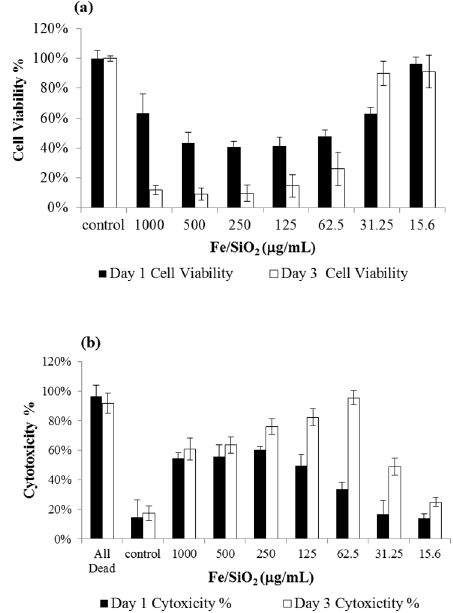
Figure 5. Results of ( a ) CCK-8 and ( b ) LDH assays of L929 cells after incubation with SiO 2 @Fe/SiO 2 particles at different concentrations. Data were analyzed by the Student’s t -test and are presented as the mean ± SD; n = 6, * p < 0.05).